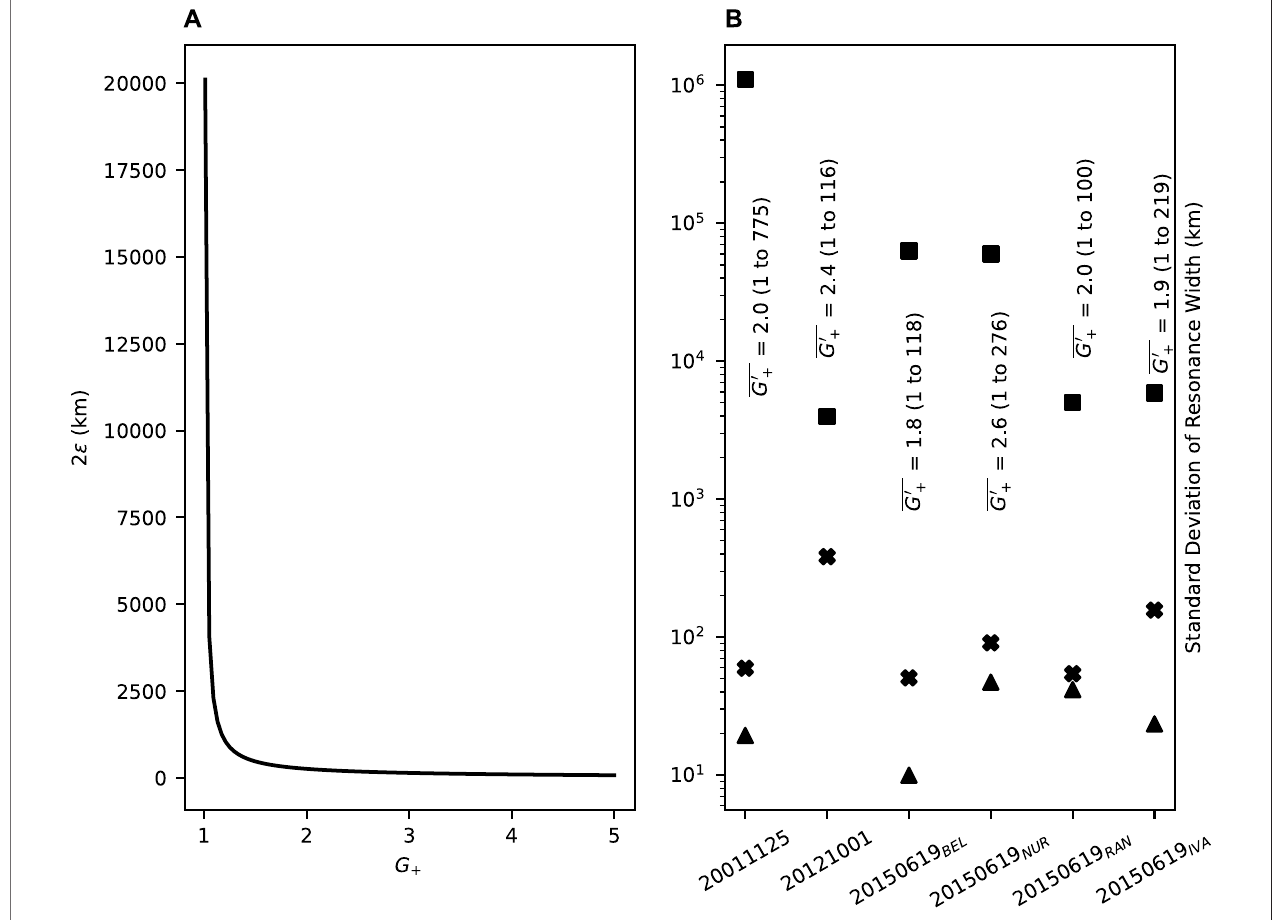
FIGURE11|(A) Plotofthevariationof2 ε with G + from Eq.5 ,with β =200 km. (B) Standarddeviationsofthe2 ε distributions fortheFWHM(triangle),APM(cross), andADM(square)obtainedfrom σ amp =15%forthe25November2001,1October2012,andthefourlatitudinalslicesofthe19June2015interval.Themeans ( G + ′ ) and ranges of G + ′ are also